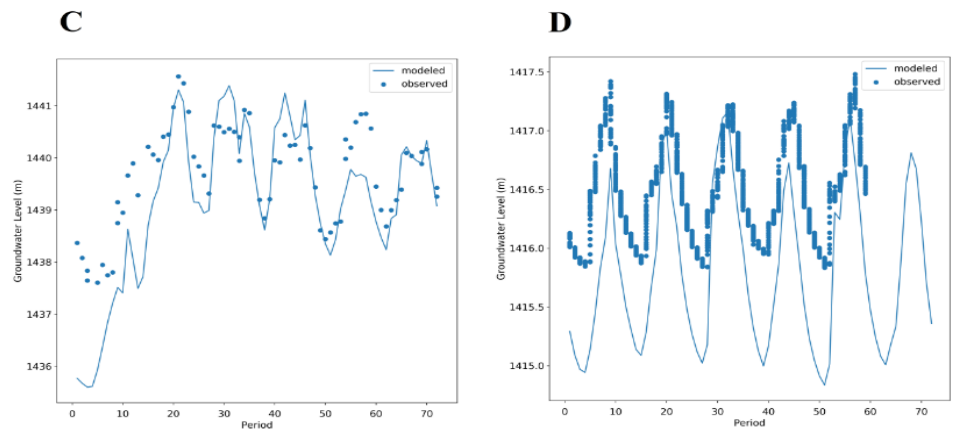
Figure 6. Figure ( A ) shows the root mean square error (RMSE) of comparing the modeling head and observations with different efficiencies. Figure ( B ) is the 1:1 plot of modeling head vs. observed head. Figure ( C ) and ( D ) are the time series of comparison of modeled and observed head in different locations of the study area.